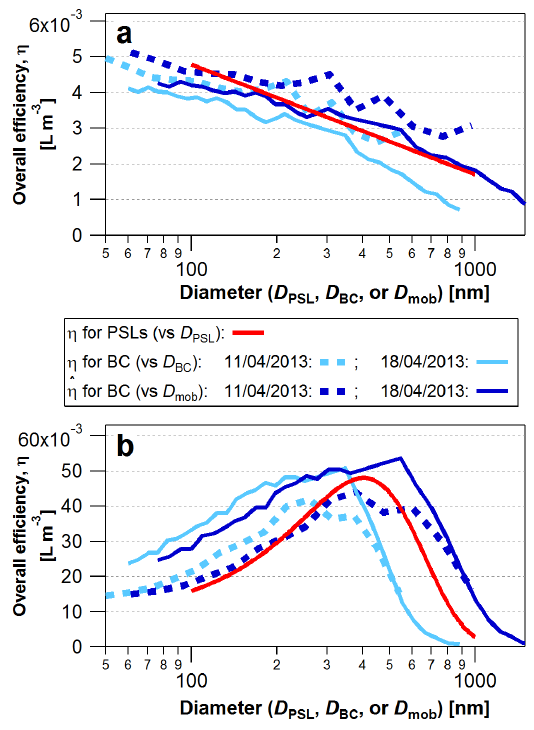
Figure 2. Overall nebulizer efficiency of (a) the Collison-type neb- ulizer and (b) the PSI-CETAC nebulizer for PSLs and polydisperse Aquadag (AQ) relative to that of the Apex Q on two different days. D PSL represents PSL diameter; D BC stands for BC mass equivalent diameter; D mob is mobility